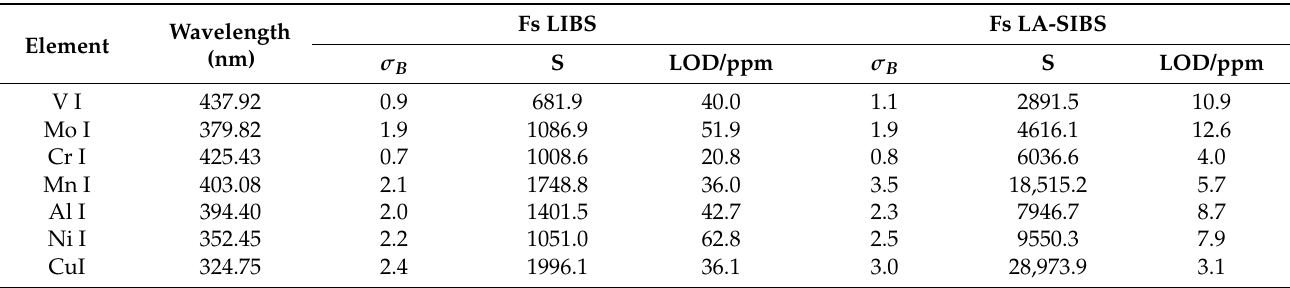
Table 2. LODs of vanadium, molybdenum, chromium, manganese, aluminum, nickel, and copper in steel alloy obtained with fs LIBS and fs LA-SIBS